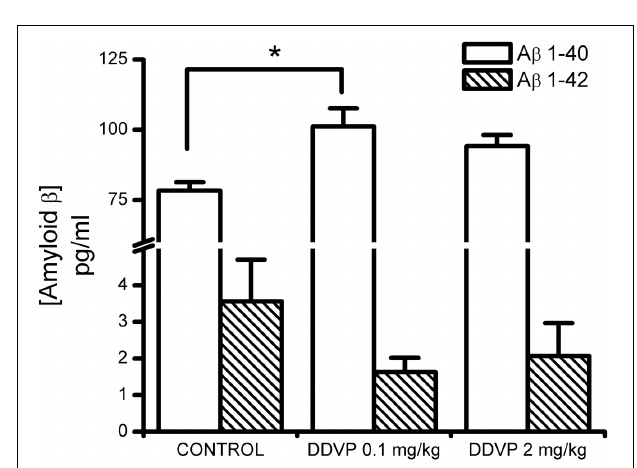
FIGURE 5 | Effect of sub-chronic treatments with low and high DDVP doses on the endogenous concentrations of Ab 1 − 40 and Ab 1 − 42 . Both DDVP doses produced increases in the endogenous concentration of A β 1 − 40 , which were statistically significant for the low-dose condition. ∗ p <